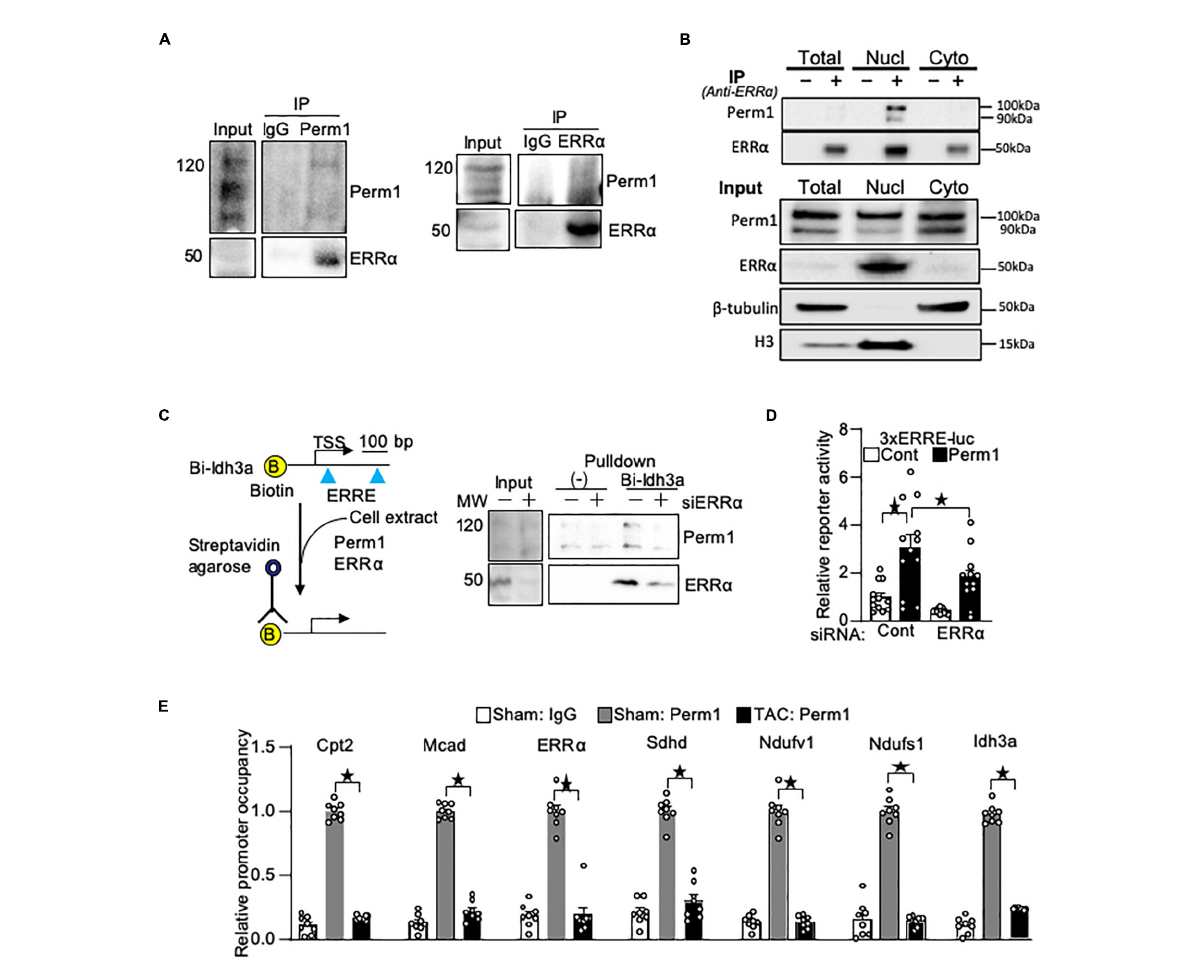
FIGURE6 PERM1 interacts with ERR α and activates ERRE in an ERR α -dependent manner. (A) PERM1 binds to ERR α in the adult mouse heart. (B) Co-IP assay of subcellular fractionation from the mouse adult heart shows that PERM1 binds to ERR α in the nucleus. (C) In vitro DNA binding assay using biotin-labeled DNA comprising the promoter of Idh3a (ERR target gene) and cardiomyocyte lysate shows that PERM1 bound to the ERRE of the ERR target gene, which was partly inhibited by silencing of ERR α (siERR α ). (D) Reporter gene assays were performed in cardiomyocytes using a luciferase reporter gene driven by 3 repeats of EER response element (3xERRE-luc) ( n = 12/group). Adenovirus-mediated overexpression of PERM1 increased the ERRE activity (white bar vs. black bar, scrambled-siRNA), which was partially inhibited by silencing of ERR α (siERR α ). Cont: control (adenovirus-null), PERM1: adenovirus-PERM1 (overexpression) (E) ChIP-PCR was performed with anti-PERM1 antibody in the mouse heart that was subjected to either sham or 4 weeks of transverse aortic constriction (TAC) surgery ( n = 8/group). PERM1 was localized to the flanking promoter region (ERRE) of the well-known ERR target genes ( Ctp2 ; Mcad ; ERR α ; Sdhd ; Ndufv1 ; Ndufs1 ; Idh3a ), which was abolished by pressure overload. * p < 0.05 (one-way ANOVA), ± SED.